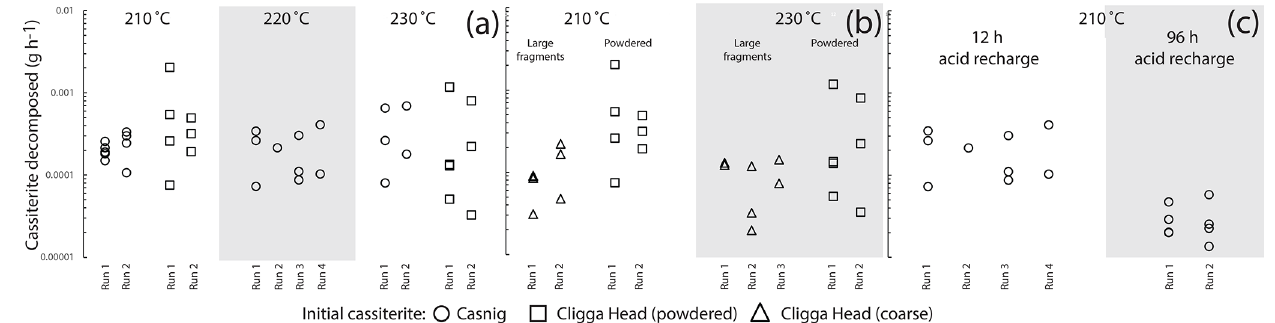
Figure 2. Plots of integrated decomposition rates for different initial cassiterite materials. Variations in mass below those induced by Br 2 diffusion into the beaker are not displayed. (a) Variation in rate over a 12h decomposition step at different temperatures within high-pressure vessels for powdered cassiterite. (b) Differences in rates between coarse fragments approximating cubes 500µm in length, and cassiterite powdered in a pestle and mortar at 210 and 230 ◦ C. (c) The difference in rate averaged over 12 to 96h decomposition steps at 210 ◦ C. See the text for